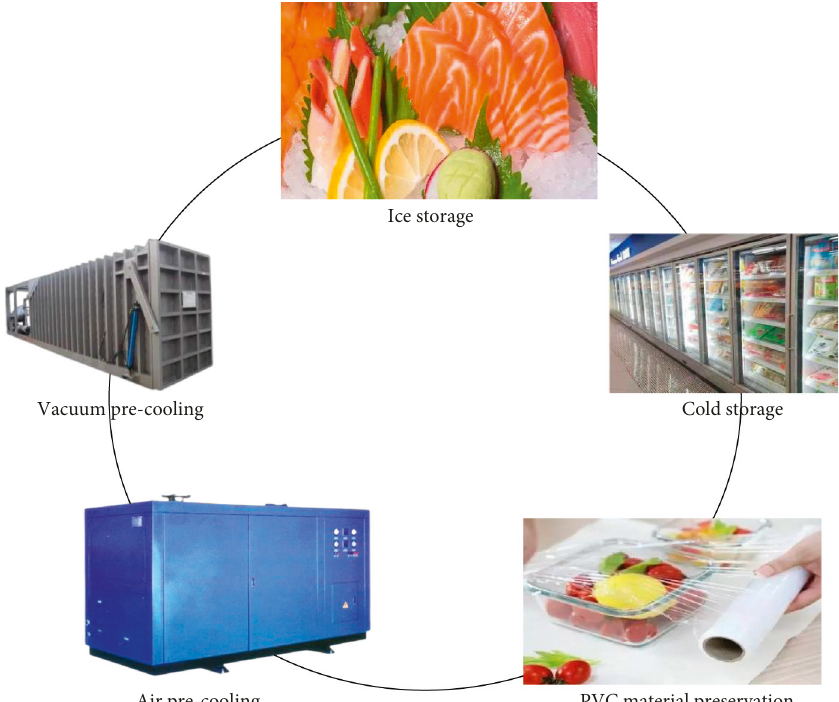
Figure 3: Commonly used preservation